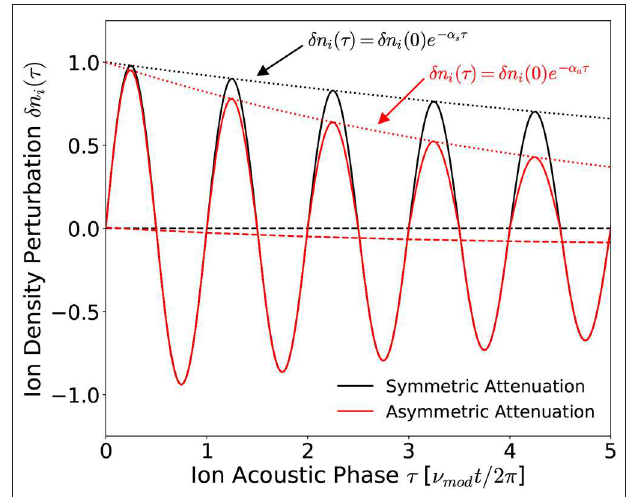
FIGURE 8 | Representative ion acoustic waveforms exhibiting symmetric α s and asymmetric α a amplitude attenuations. The time-averaged values and positive amplitudes of the waveforms are denoted by the dashed and dotted lines, respectively.